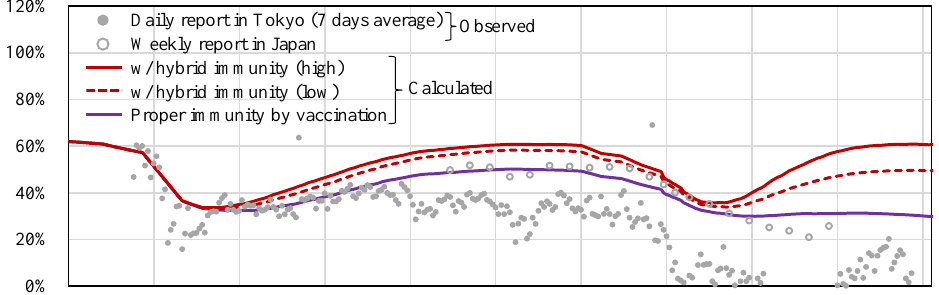
Figure 3. Time series of estimated population vaccination effectiveness (VE) in Tokyo from 1 July to 30 September 2022. Empirical estimation from reported DPC and their vaccination status is also plotted. This report ended 26 September 2022 in Tokyo and 28 August 2022 in Japan.